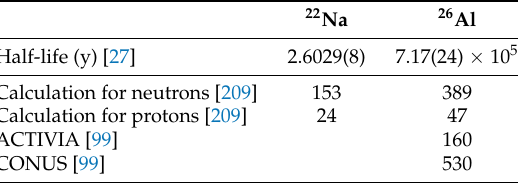
Table 10. Rates of production of long-lived radioisotopes induced in aluminum at sea level. Measurements from different calculations are presented (see text). All numbers are expressed in